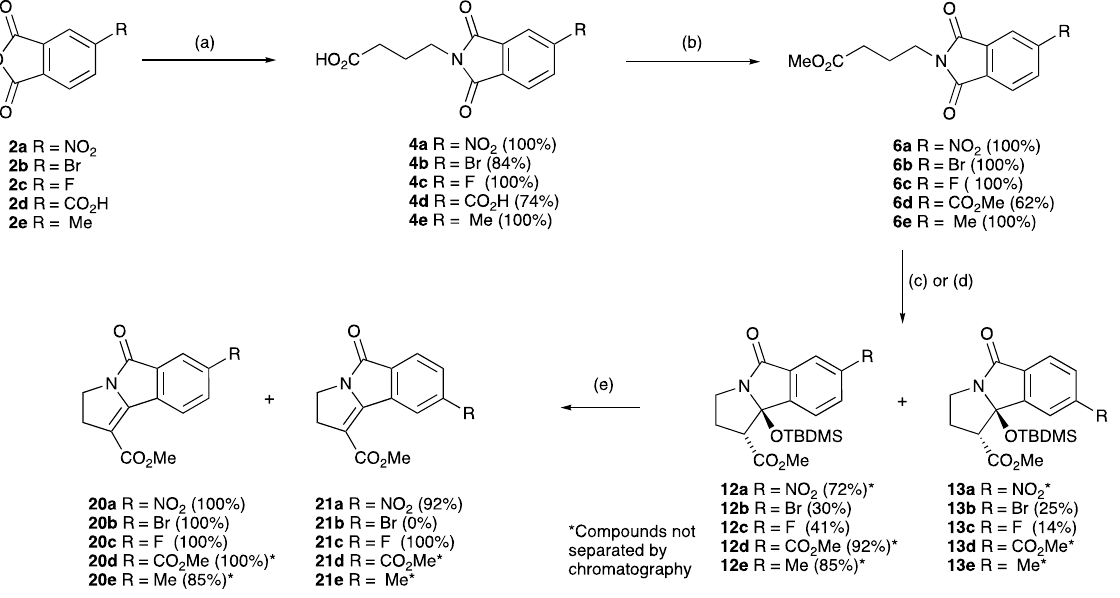
Scheme 2. Synthesis and ring closure of substituted phthalimides.